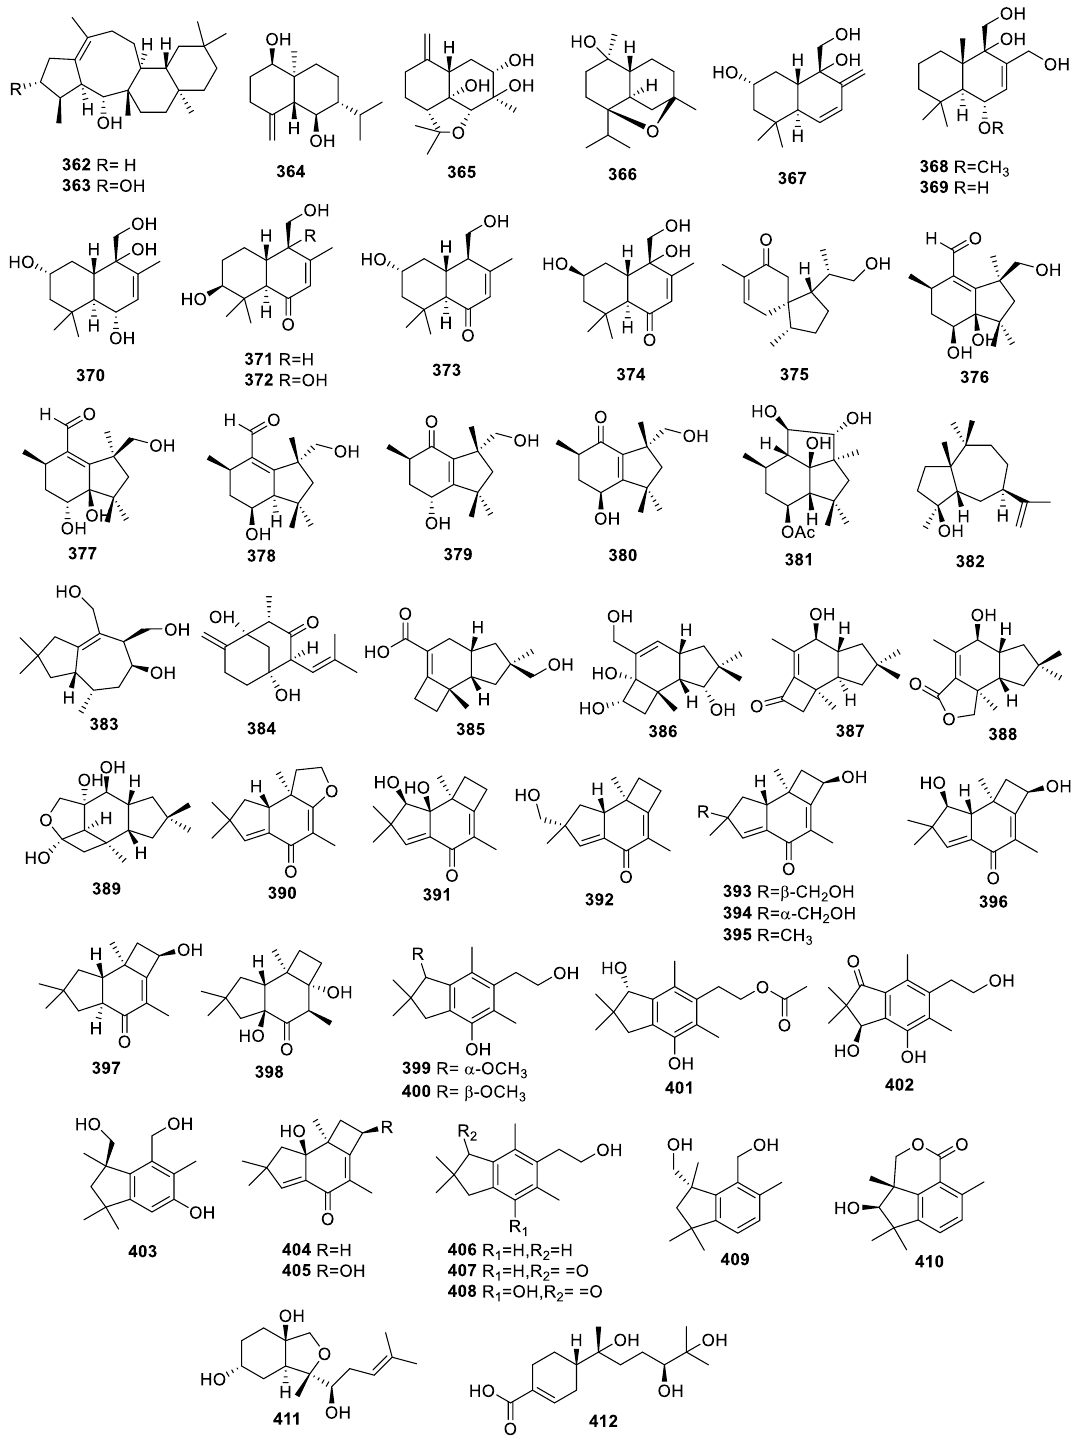
Figure 15. Chemical structures of sesquiterpenoids ( 362 – 412